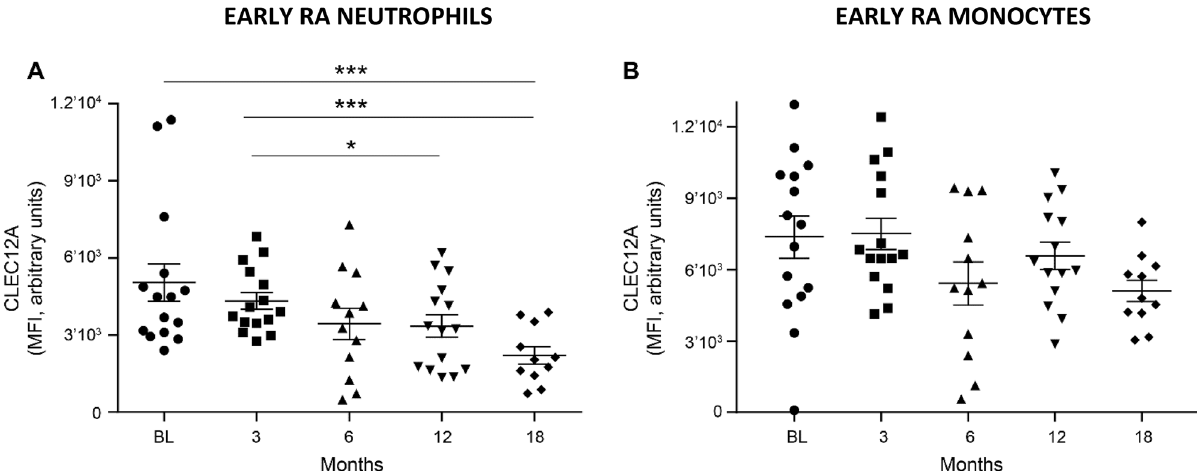
Figure 3. Neutrophil and monocyte CLEC12A expression diminishes with treatment in eRA patients. Cell- surface, CLEC12A expression was determined by flow cytometry on peripheral neutrophils and monocytes and analyzed with GEE models and Bonferroni correction. (A) Analysis of neutrophil CLEC12A expression revealed significant differences between groups ( p = 0.017). Pairwise significant difference p values are 0.0007 for baseline (BL) and 18 months, 0.018 for 3 and 12 months and < 0.0001 for 3 and 18 months. (B) Analysis of monocyte CLEC12A expression did not reveal significant differences between groups ( p = 0.081). Symbols represent individual patients at baseline (BL) and after 3, 6, 12 and 18 months of treatment. Data show the mean ± SEM. *** < 0.001 ** < 0.01 * <